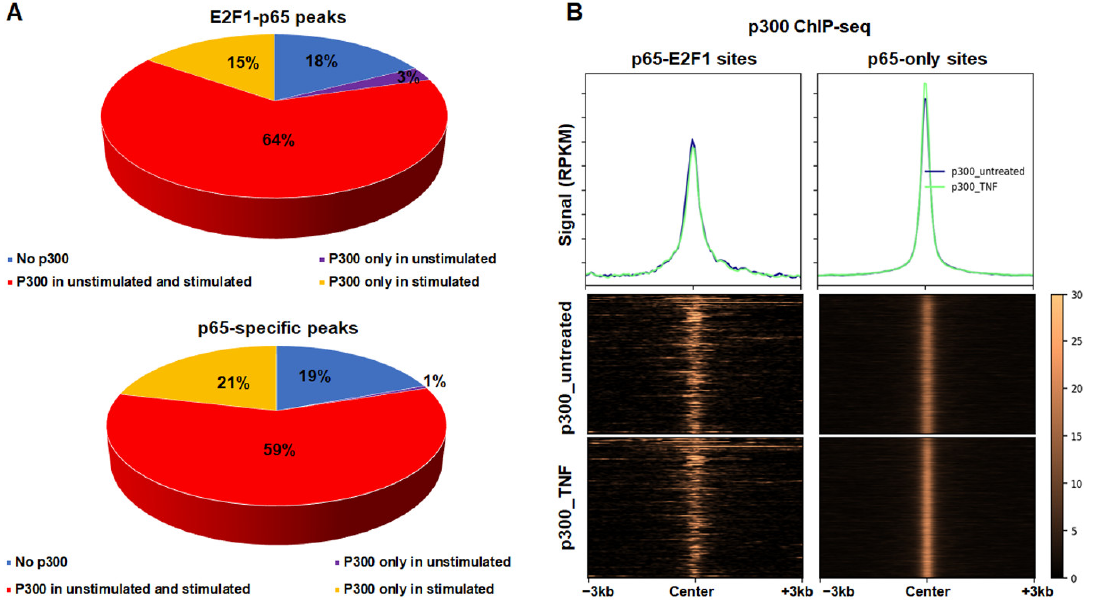
Figure 3. ( A ) Shown are E2F1-p65 common ( up ) and p65-specific peaks categorised according to